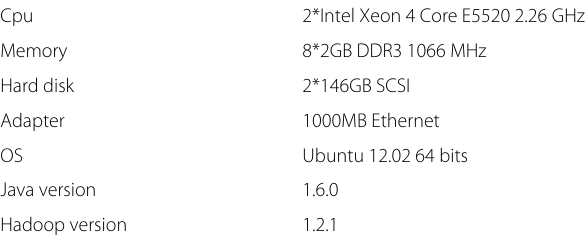
Table 2 Node configuration used for MR